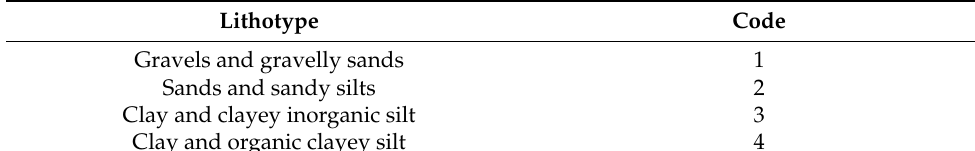
Table 3. Lithotypes and associated codes.